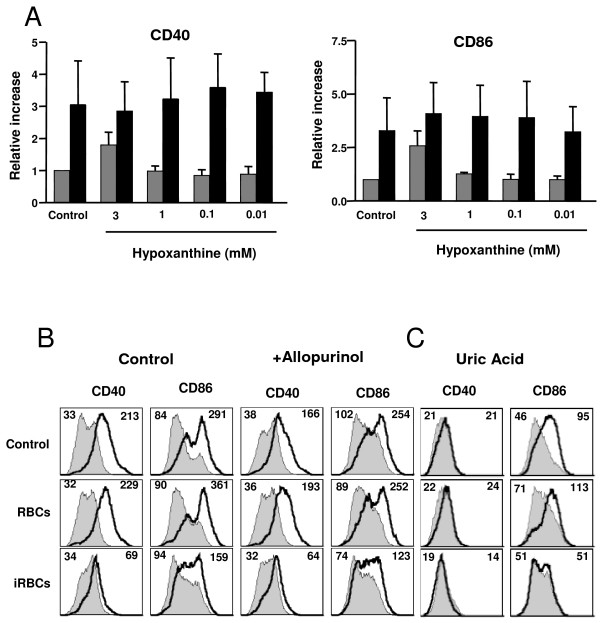
Uric acid and the inhibition of DC maturation by P. yoelii-infected erythrocytes. (A) DCs were incubated alone (Control) or in the presence of various concentrations of hypoxanthine for 24 h followed by an additional 24 h in the absence (grey bars) or presence (black bars) of 100 ng/ml LPS. Results are expressed as the relative increase in MFI over DCs incubated in media alone. Error bars represent the standard deviation of 3 averaged independent experiments. (B, C) DCs were incubated alone (Control) or with uninfected RBCs (RBCs) or P. yoelii-infected erythrocytes (iRBCs). (B) 2 mM allopurinol was added or not to the co-cultures for 24 h followed by an additional 24 h in the presence or absence of 100 ng/ml LPS. (C) Co-cultures were incubated alone for 24 h before addition of uric acid crystals for additional 24 h. FACS plots show CD40 or CD86 surface expression on DCs from control cultures (gray filled histogram) or incubated with LPS (B) or uric acid crystals (C) (black thick line). Mean fluorescent intensity (MFI) values are indicated in each plot for control and stimulated. Each FACS plot is representative of one of at least 2 independent experiments.